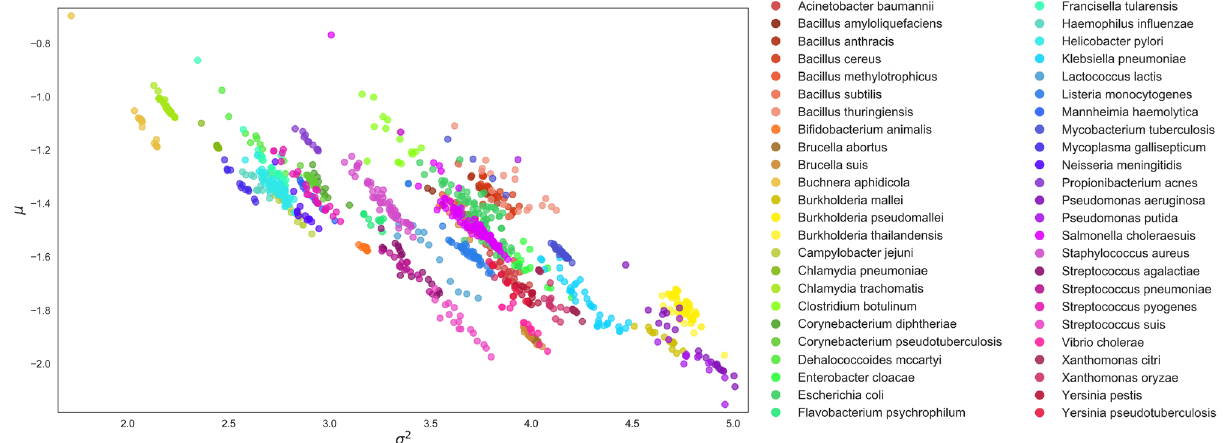
Figure 2. Distribution of species according to the model parameters. Scatter plot of Poisson Log-Normal parameters µ versus σ 2 obtained fitting the protein domains RSAs. Only species represented by at least 10 different strains were included in the plot, for a total of 1173 bacterial genomes which belong to 48 different species. Different colors represent different species as indicated in the